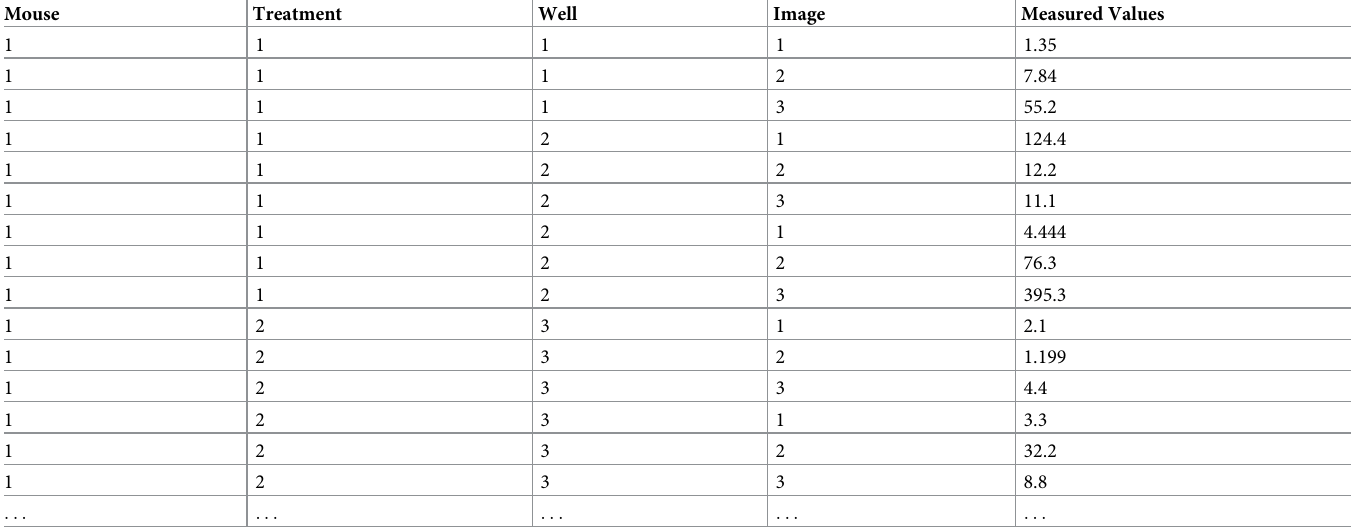
Table 1. Formatted dataset corresponding to the design in Fig 2. Mouse